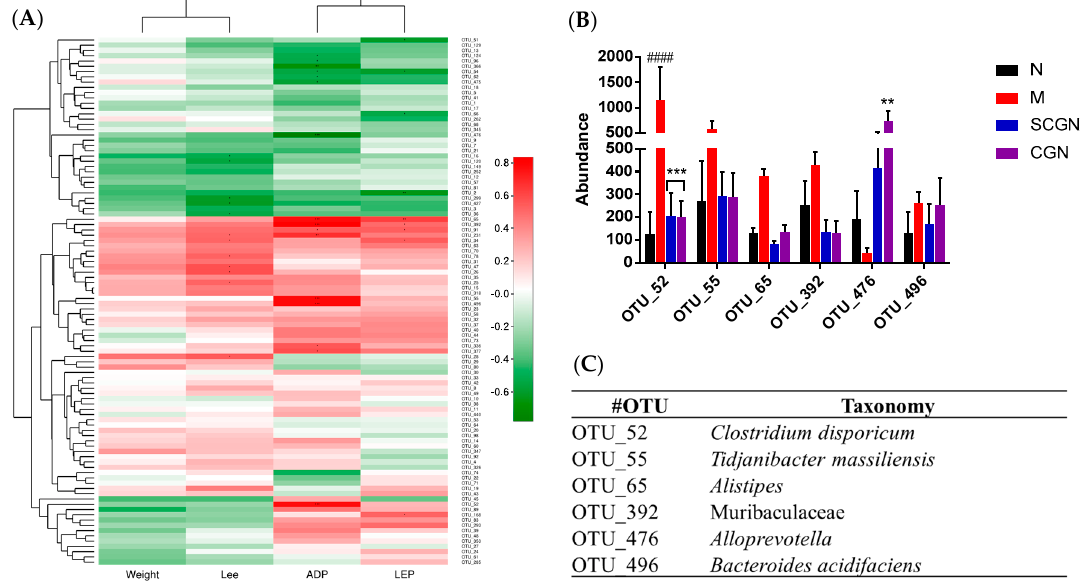
Figure 8. Influence of gut microbes on phenotype and biochemical characteristics: ( A ) Heatmap showing Spearman correlation rank between gut microbes with weight, Lee’s obesity index (Lee), adiponectin (ADP), and leptin (LEP) levels of mice; ( B ) abundance of operational taxonomic units (OTUs) correlated adiponectin levels in mice; ( C ) table showing the taxonomy classification of OTUs in ( B ). Pearson correlation ** p > 0.6, *** p > 0.75. Statistical significances were calculated using one-way ANOVA with Tukey post-test where appropriate (** p < 0.01, *** p < 0.0005, #### p < 0.0001); # denotes versus N, * denotes versus